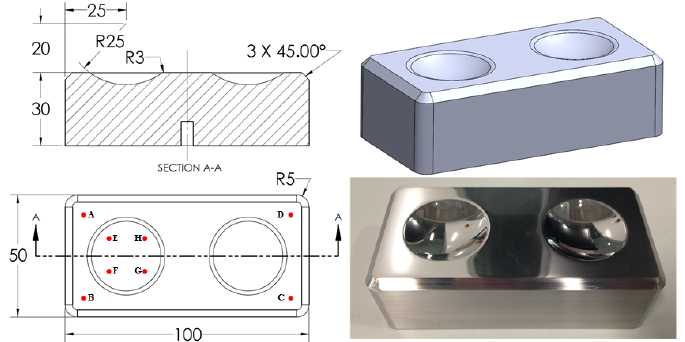
Figure 16. The designed and machined workpiece and the repeated measurement positions (A–H) (unit in mm).